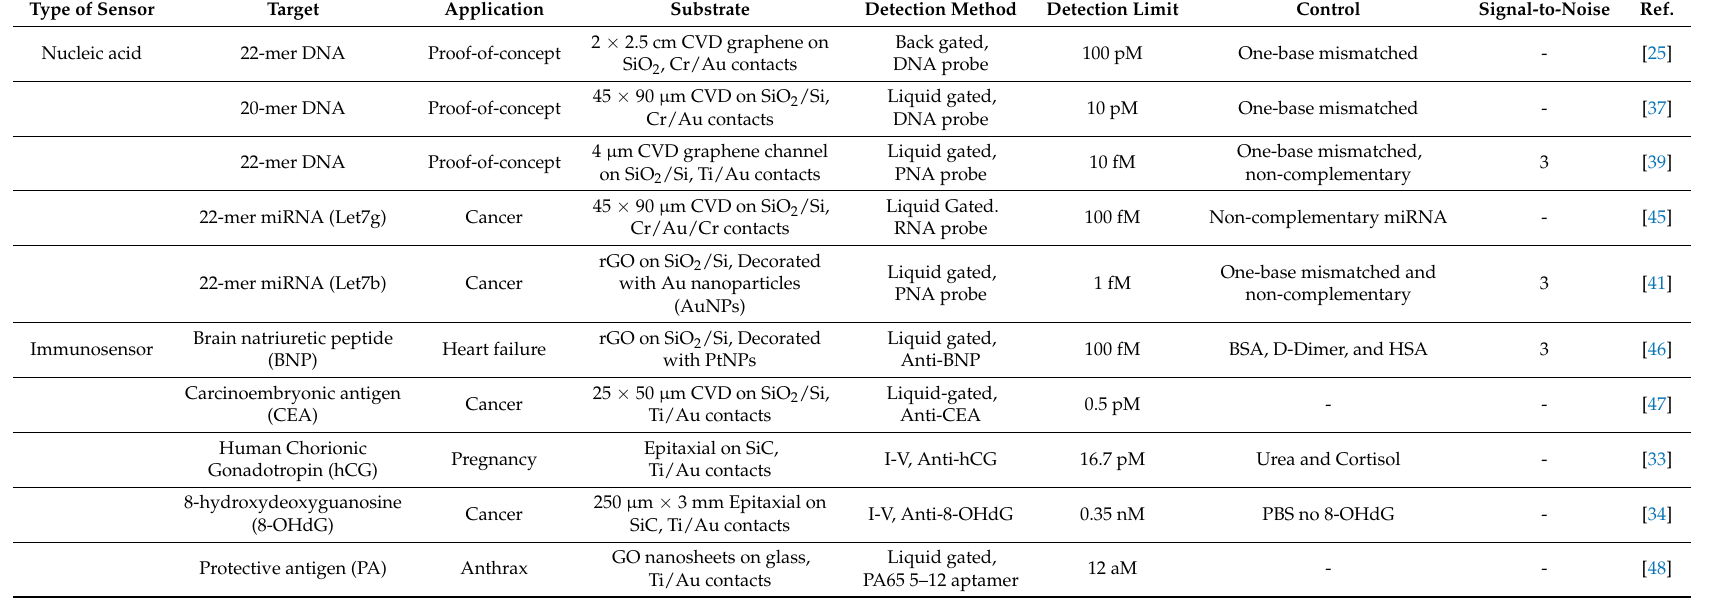
Table 1. A list of graphene-based field effect transistor (G-FET) biosensors currently reported in the